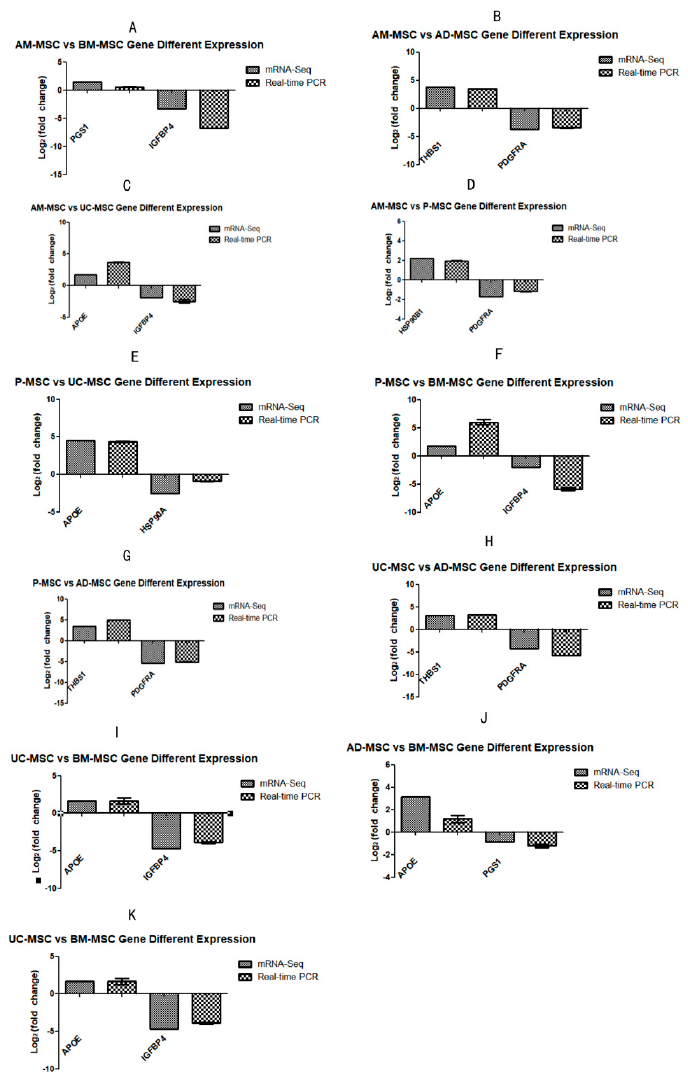
Figure 6. Validation of RNA-Seq data by employing qRT-PCR for the expression of Apolipoprotein